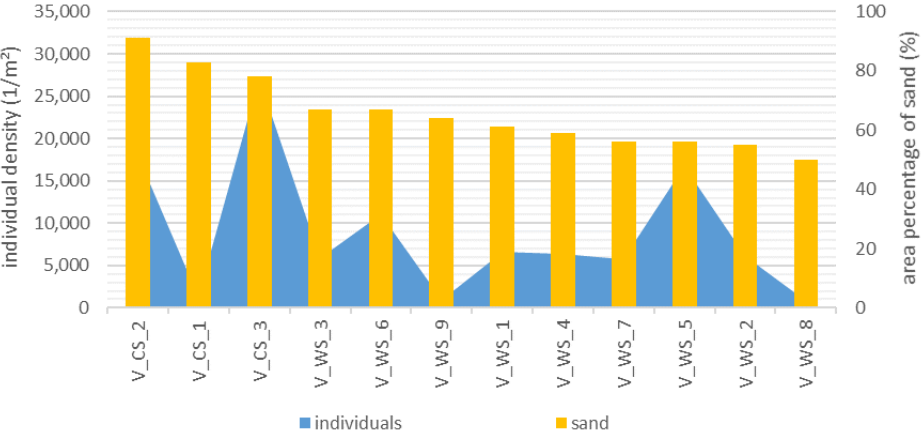
Figure 10. Individual density per m 2 as a function of the area percentage of sand (%) in WS and CS of Verlorenwasser (V) sorted according to the proportion of sand.